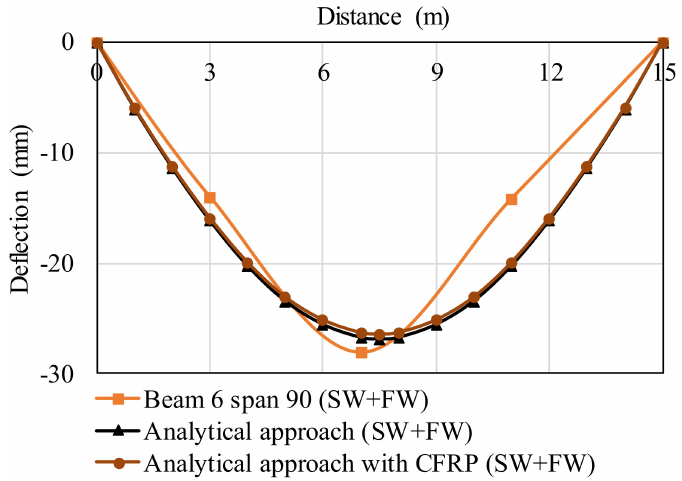
Figure 8. The deflection of the beam obtained from both field measurement and ETABS